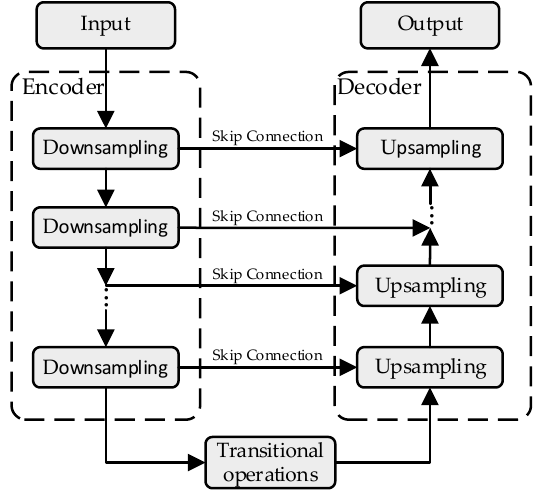
Figure 1. The architecture of U-Net.